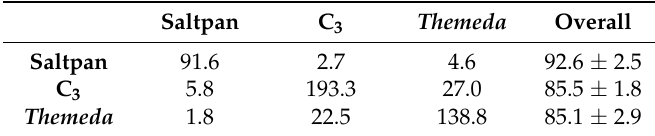
Table A2. Mean confusion matrix for reduced-HSR three-class classification results. Confusion values are given as a count value, and overall accuracies as a percentage with standard deviation.